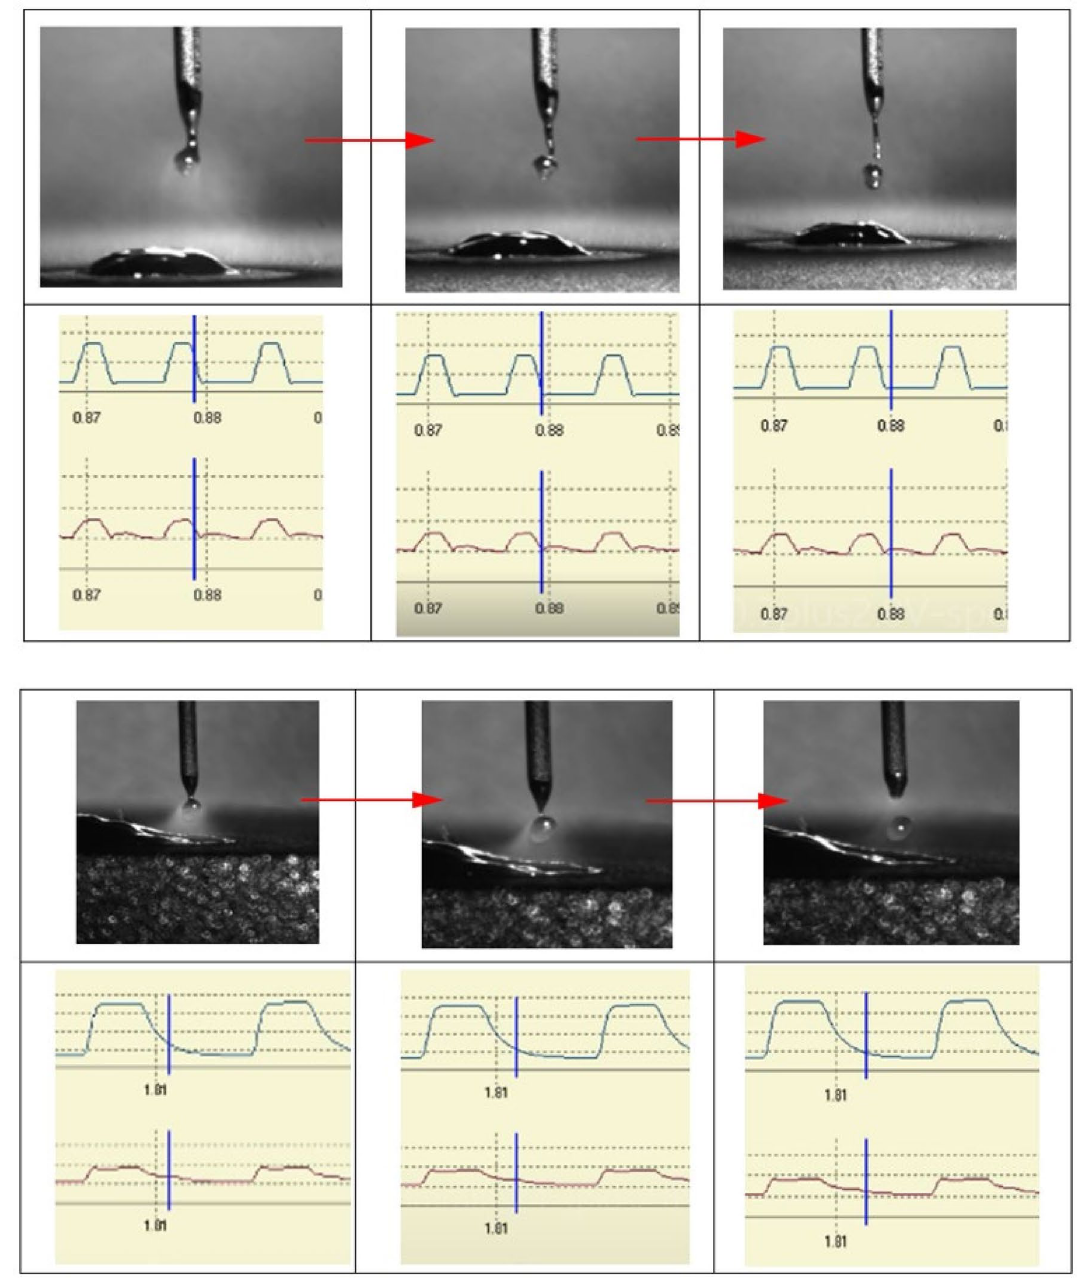
Fig. 16 The top image shows droplet detachment sequence with a linear waveform and the bottom